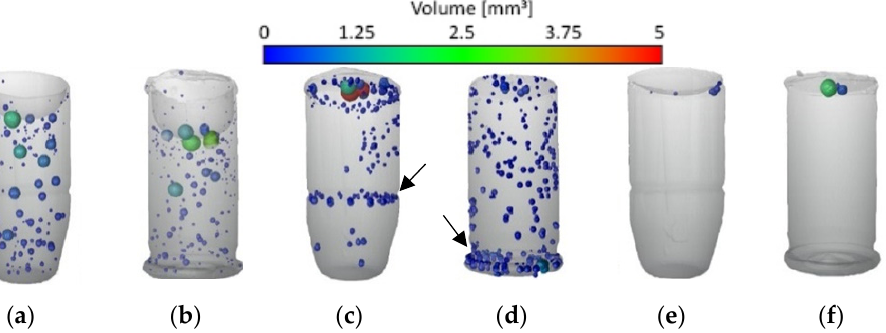
Figure 5. 3D models of specimens reconstructed with computed tomography Images of series 2 (VC) ( a ), ( b ); series 7 (HAVC) ( c ), ( d ), series 13 (HAVPC) ( e ), ( f ). Table 5. Results of porosity examinations for the cast specimens from series 2 (VC), 7 (HAVC), and 13 (HAVPC).